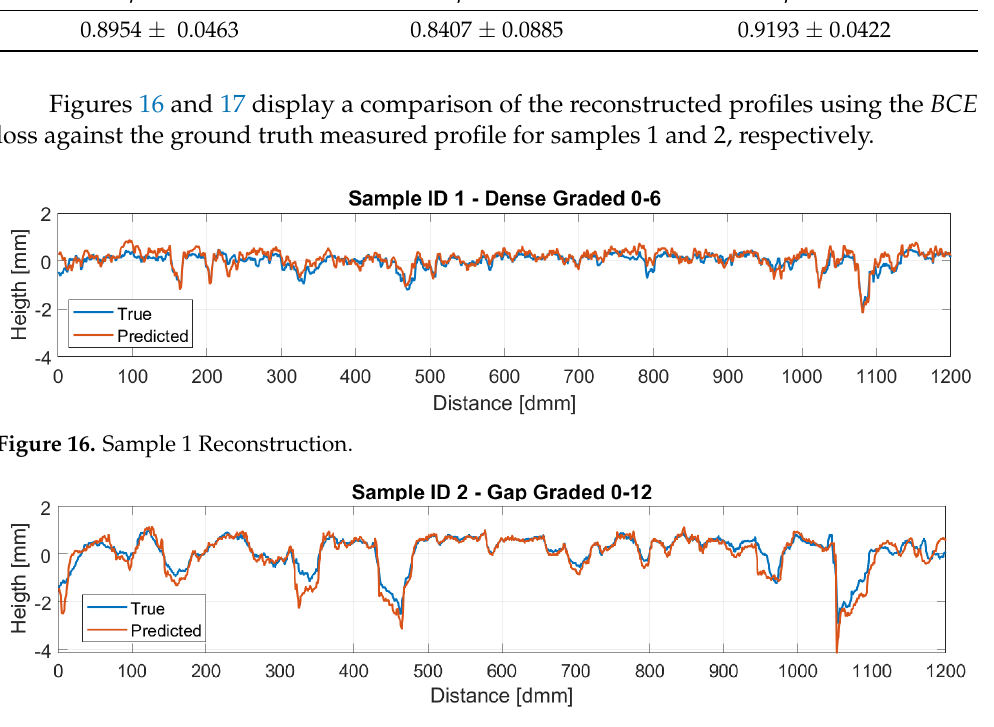
Figure 17. Sample 2